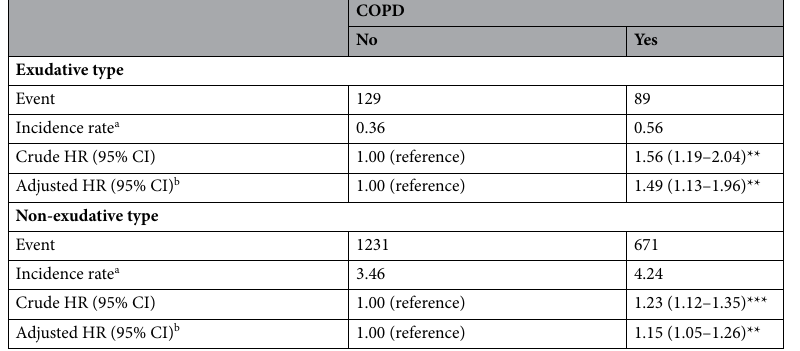
Table 4. Incidences and hazard ratios of exudative and non-exudative age-related macular degeneration for patients with COPD compared to individuals without COPD. CI, confidence interval; COPD, chronic obstructive pulmonary disease; HR, hazard ratio. ** p < 0.01, *** p < 0.001. a Incidence rate per 1000 person- years. b Multivariable analysis including age and comorbidities of hypertension, diabetes, hyperlipidemia, CLD, CKD, and rheumatic disease.